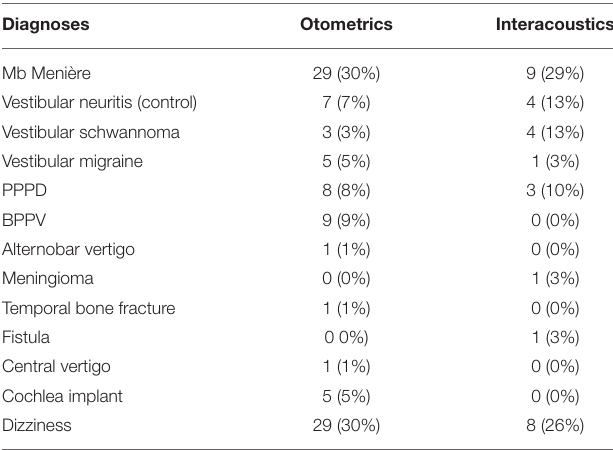
TABLE 1 | The different diagnoses for the patients that performed video head impulse test (vHIT) with the different equipment. Diagnoses Otometrics